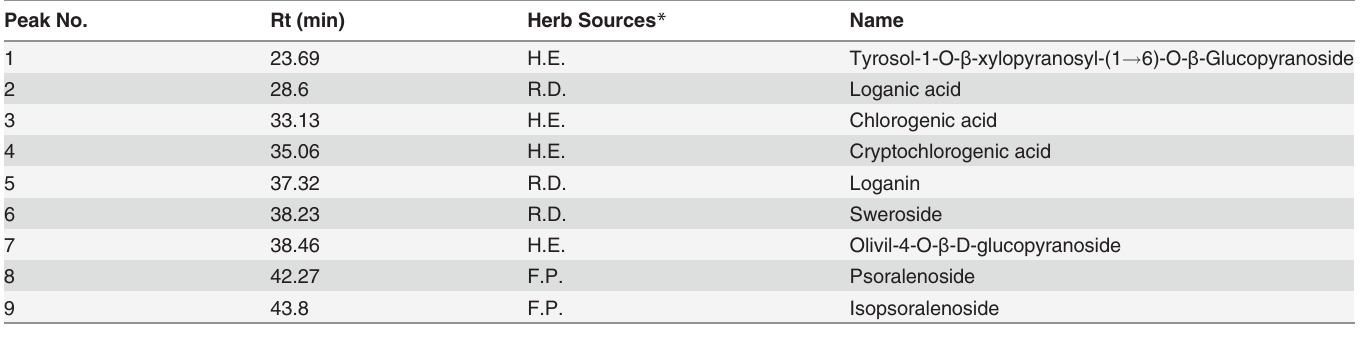
Table 5. Rention times, names and sources of the nine compounds identi fi ed from XLGB-B fraction. Peak No. Rt (min)